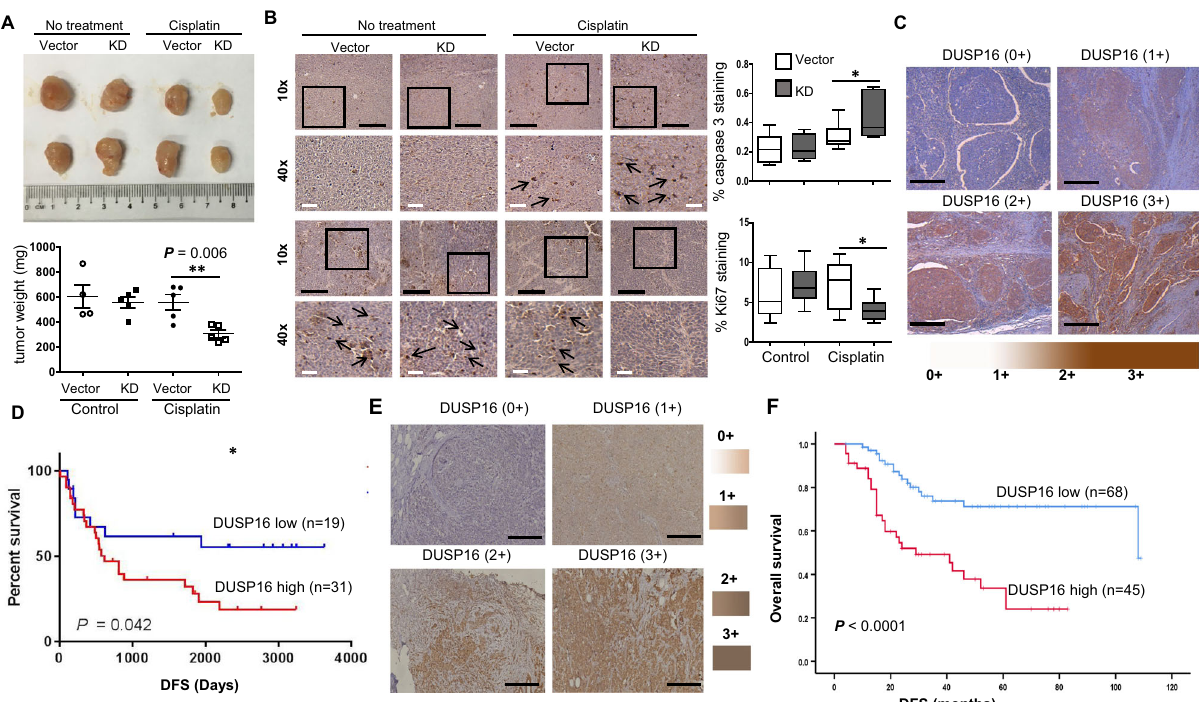
Fig. 7 DUSP16 knockdown in C666-1 cells resulted in increased sensitivity to cisplatin in vivo and DUSP16 levels were inversely associated with head and neck squamous cell carcinoma (HNSCC) patient and breast cancer patient survival. A Mice were inoculated with control or DUSP16-KD cells. Cisplatin was injected at 3 mg/kg body weight every 3 days. After 20 days, tumors were harvested, and the sizes and weights were measured. The data are expressed as dots representing the weight of each tumor; the scale bars are the mean ± SEM of tumor weights from 4 (the vector control group) or 5 mice (the other groups) of the representative experiment. Statistical analysis was performed using two-tailed unpaired t -test. B Representative images of immunohistochemistry analysis for cleaved caspase 3 and Ki67 staining of tumor sections were shown. Boxed regions were magni fi ed and presented under the respective panels. Black arrows highlight the caspase 3 and Ki67 staining, respectively. Box-and-whisker plots show mean values ± SEM of cleaved caspase 3 and Ki67 staining from each group of mice ( n = 4). Boxes correspond to the 25th, 50th/median and 75th percentiles; whiskers denote maximum and minimum. Black scale bars = 200 μ m, white scale bars = 50 μ m. Statistical analysis was performed using two-tailed unpaired t -test. * P < 0.05. The data are representative of three experiments with similar results. C Representative images of HNSCC specimens ( n = 50) showing negative (0 + ), low (1 + ), intermediate (2 + ), and high (3 + ) staining of DUSP16 in tumor cells. Black scale bars = 200 μ m. D Patients with higher DUSP16 expression showed lower disease-free survival (DFS) compared to patients with low DUSP16 expression (log-rank test, two-sided, P = 0.042). E Representative images of breast cancer specimens ( n = 113) showing negative (0 + ), low (1 + ), and high (3 + ) staining of DUSP16 in tumor cells. Black scale bars = 200 μ m. F Among the 113 breast cancer patients (age 28 – 64) treated with cisplatin, carboplatin, or lobaplatin after surgery, high DUSP16 protein expression in their tumors was associated with lower disease-free survival compared to patients with low DUSP16 expression (log-rank test, two-sided, P ˂ 0.0001). Source data are provided as a Source data fi